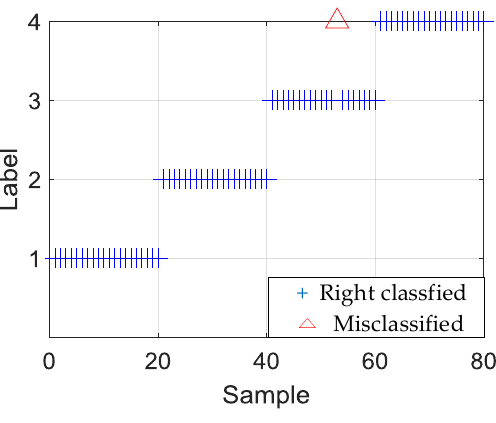
Figure 9. Experiment 1 of inner fault degree recognition.